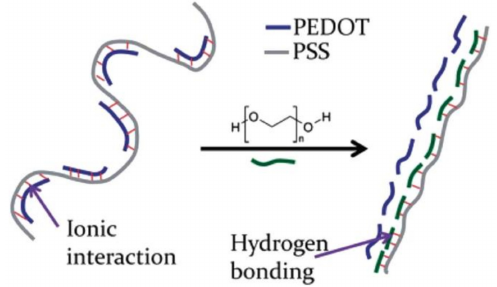
Figure 6. Schematic illustration of the mechanism involved in the enhancement of PEDOT:PSS conductivity in presence of PEG. Reproduced from [78] with permission of The Royal Society of Chemistry.